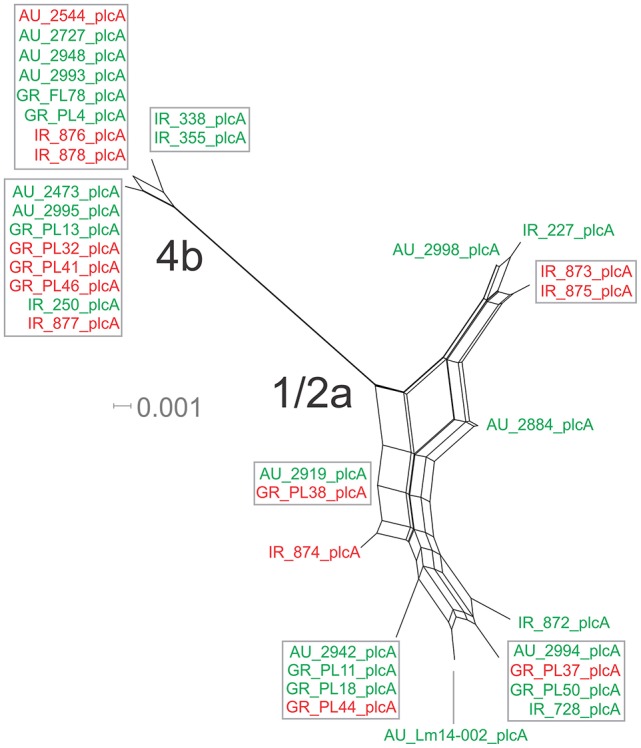
Phylogenetic network applied to virulence gene plcA using the Neighbor-Net algorithm. L. monocytogenes strains represented food environment isolates (green color) or clinical isolates (red color), isolated in Ireland (IR), Greece (GR), and Australia (AU). Strains clustered together in a box represent identical nucleotide sequence.